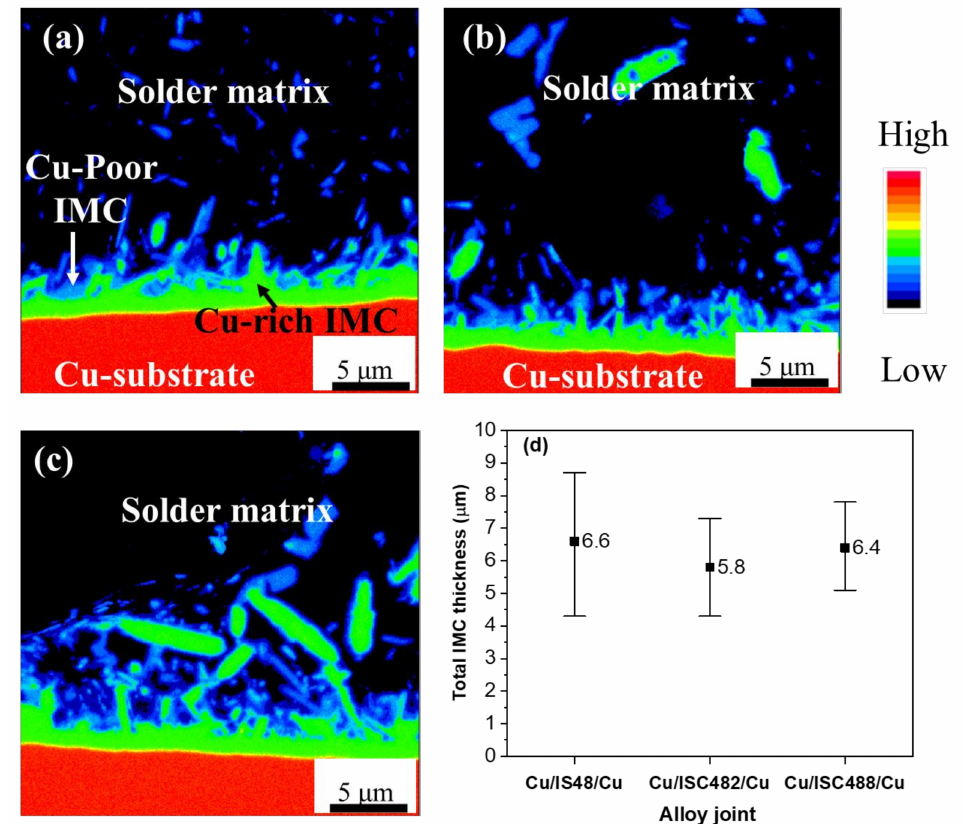
Figure 4. ( a – c ) Typical EMPA Cu maps images, and ( d ) total thickness of the IMC layer in Cu/IS48/Cu, Cu/ISC482/Cu, and Cu/ISC488/Cu